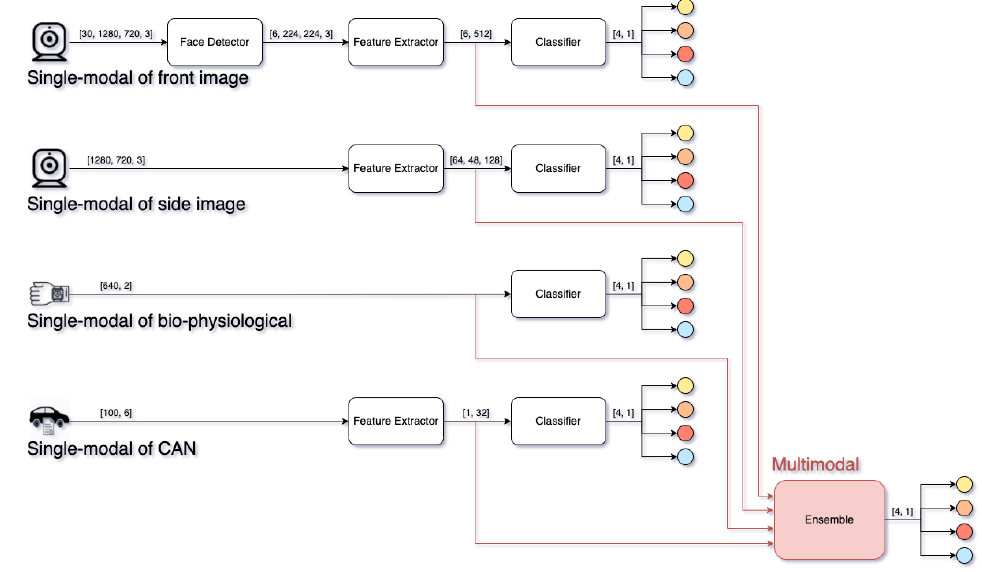
Figure 11. Deep learning-based personalized driver emotion recognition